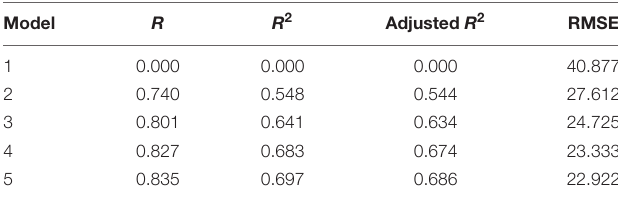
TABLE 2 | Regression model summary of